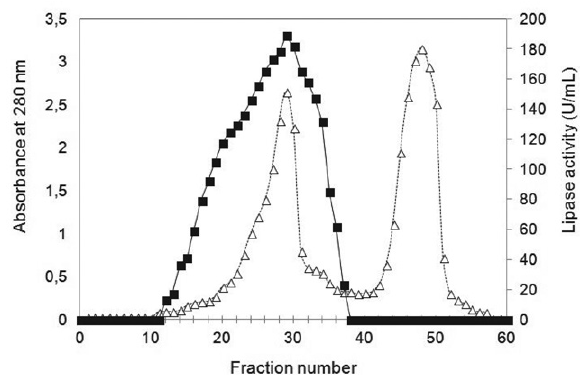
Figure 6 . Elution profile of AKL29 obtained by gel filtration using chromatography on Sephacryl S-75. The column (3 cm × 160 cm)